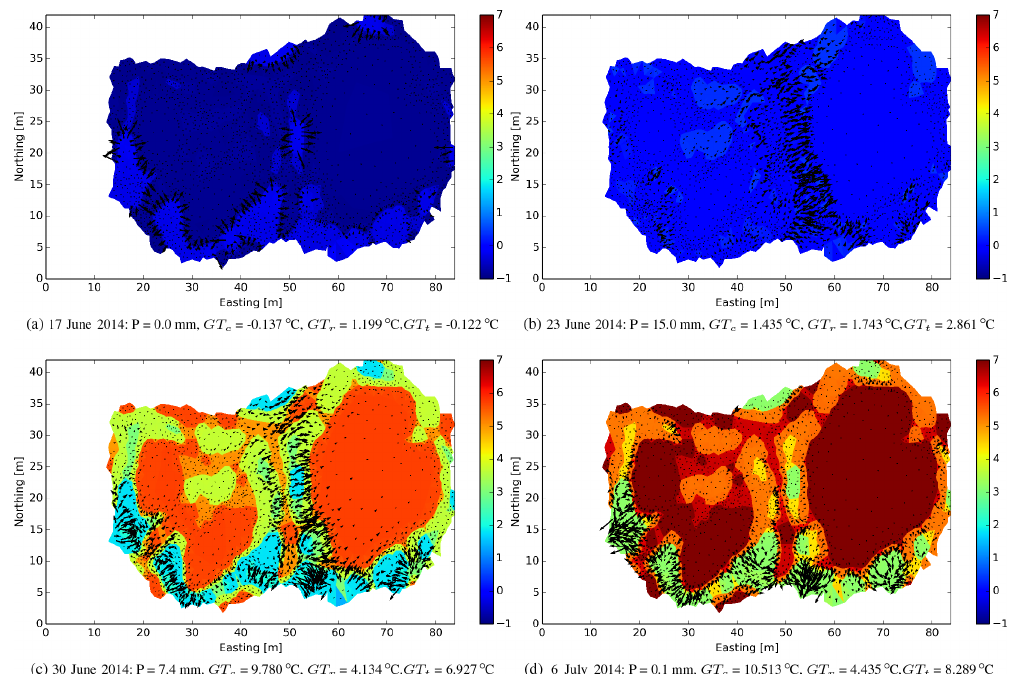
Figure 12. Lateral water flow velocity fields at Site A during the early summer. In the horizontal cross section plot for Site A, the background color shows the soil temperature distribution while the vector arrows show the magnitude and direction of lateral flow fields. ( P is the total daily precipitation; GT c , GT r and GT t are the mean ground surface temperatures at center, rim and trough respectively.